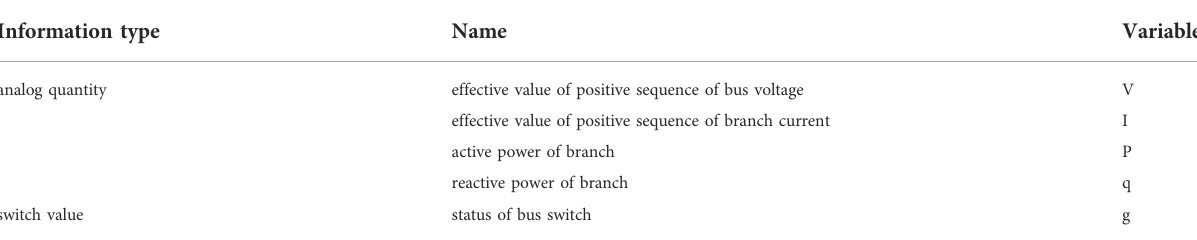
TABLE 2 Monitoring data required in topology identi fi cation.